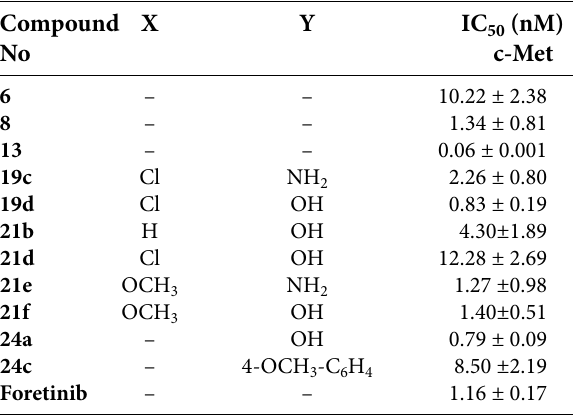
Table 3. c-Met enzymatic activity and line of the most potent com- pounds